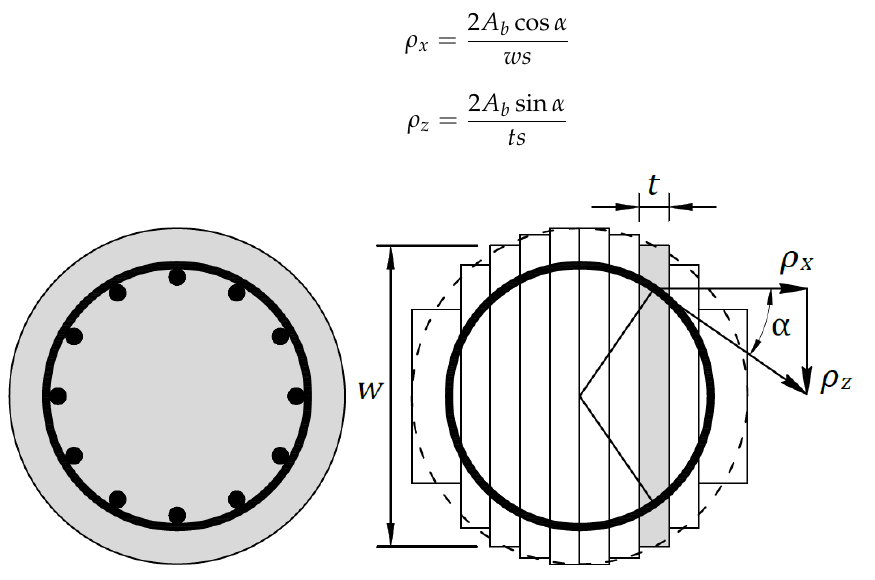
Figure 5. Discretization of circular column and components of hoop/spiral reinforcement.